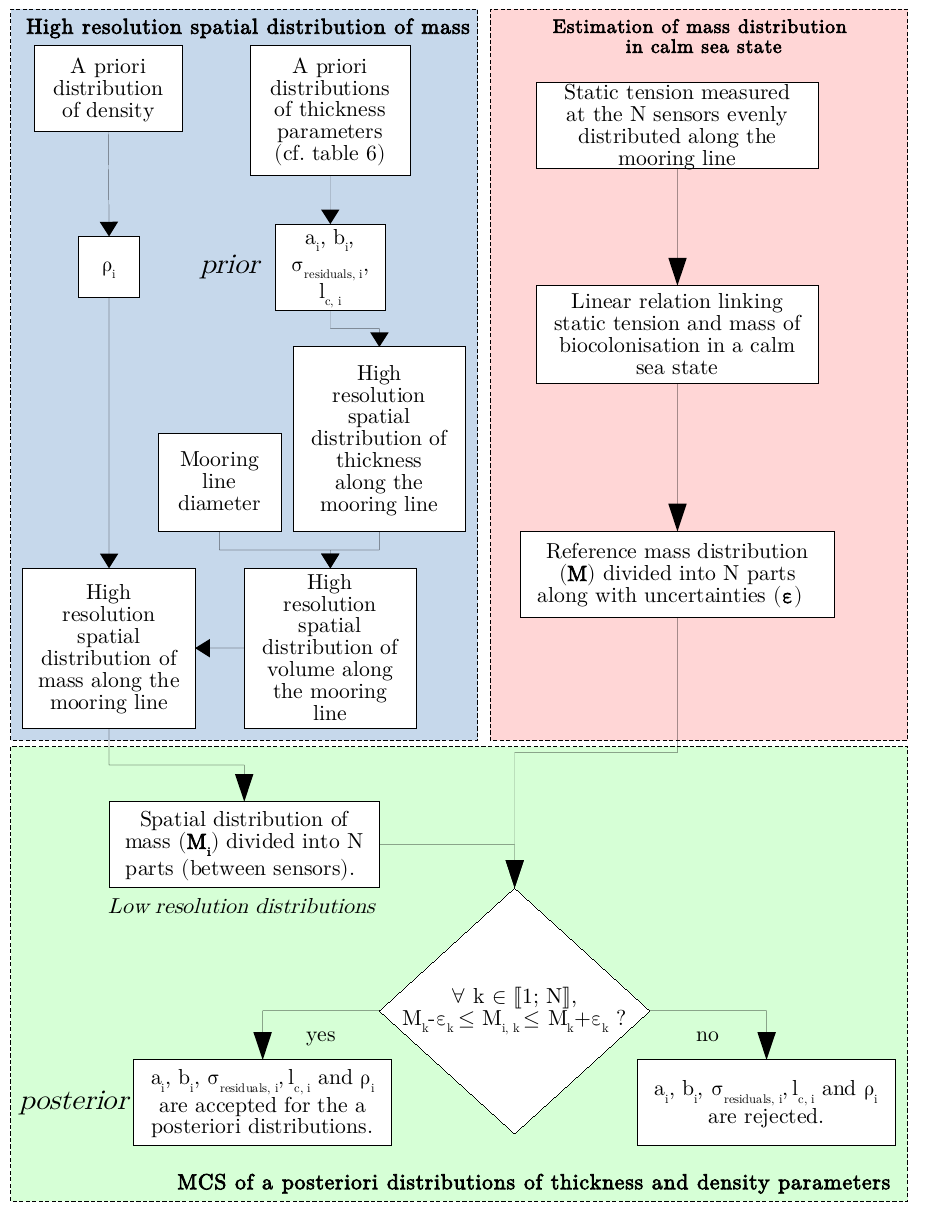
Figure 16. Building samplings of posterior distributions of thickness and density parameters in calm sea state from tension